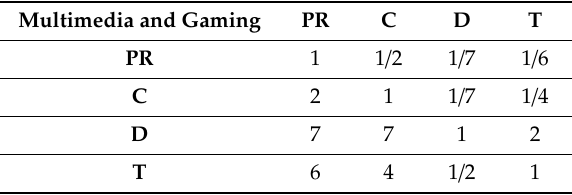
Table 5. The pairwise comparison matrix for the network attributes for multimedia and gaming applications.